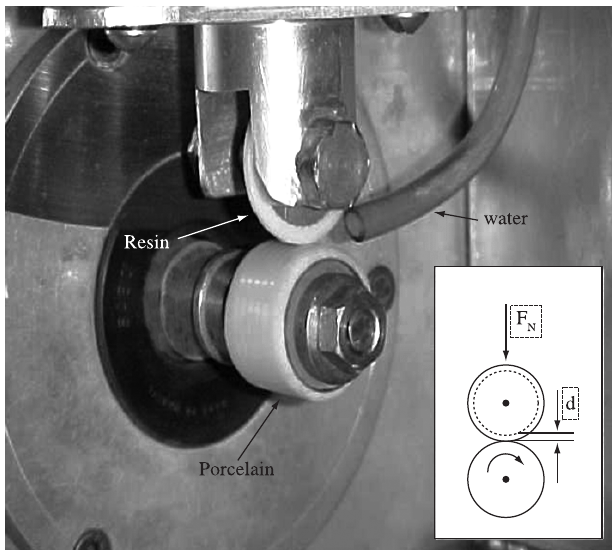
Figure 2. Detail of the dynamic contact between the porcelain-coated driv- ing cylinder and the resin-coated sample holder to be tested (lower portion of the test bench).